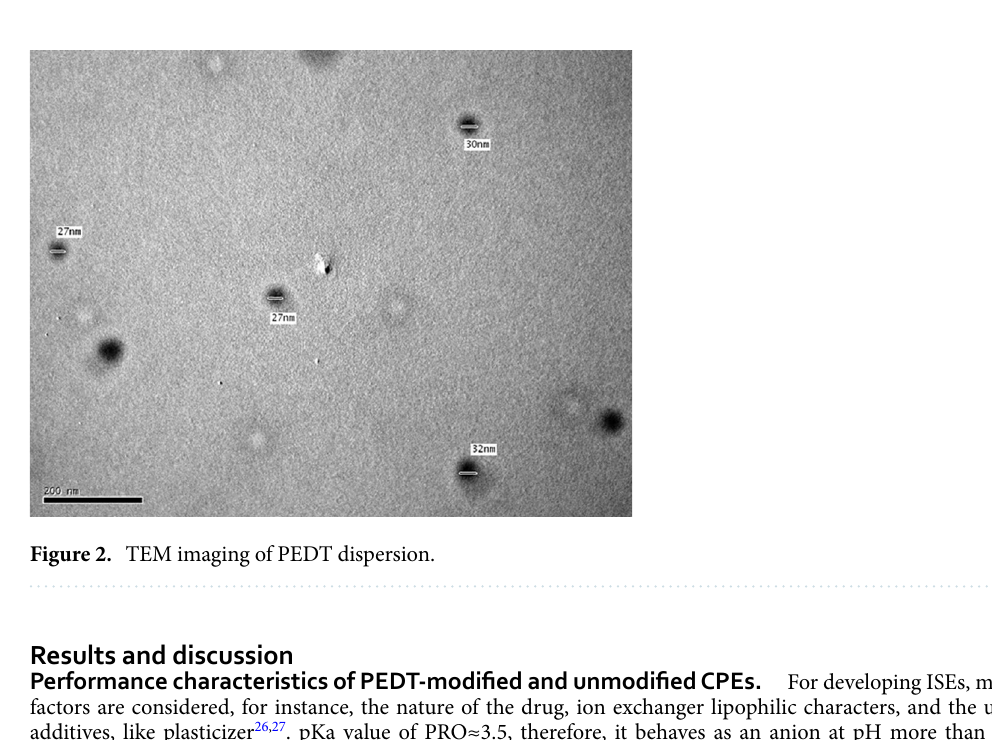
Figure 1. Chemical structure of probenecid.